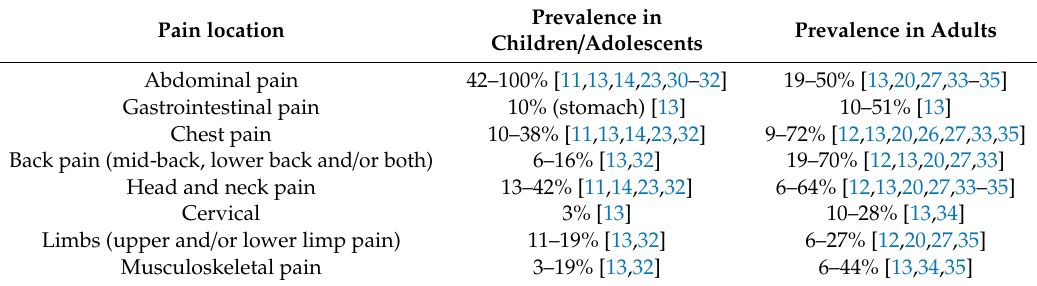
Table 1. Pain regions and prevalence in children / adolescents and